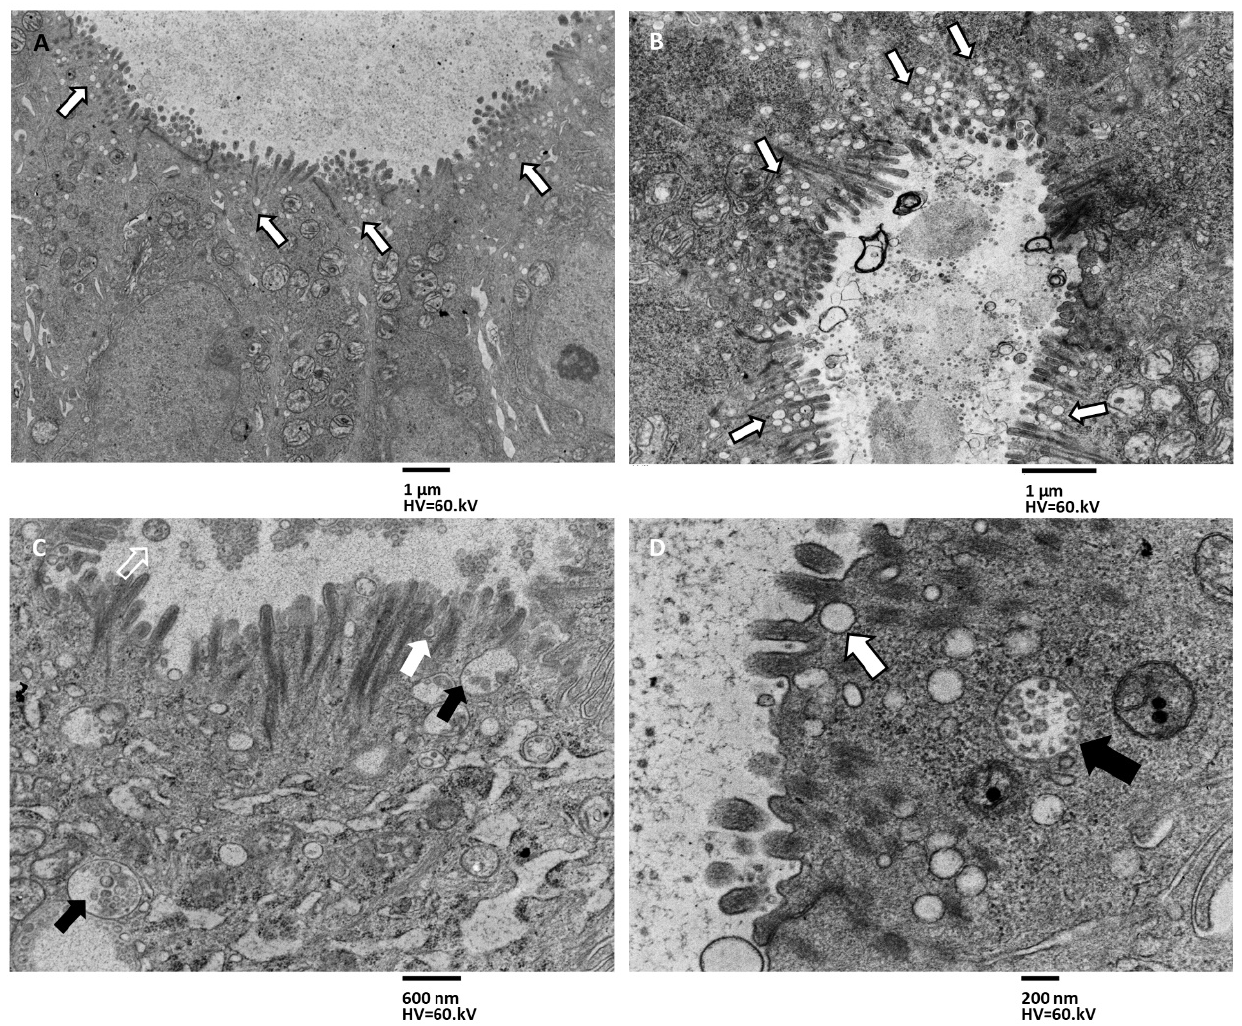
Figure 6. TEM images of exosomes secretion pattern in xenografts, apical surface secretion. ( A ) Numerous MVBs crowd the apical portion of pseudocyst lining epithelial cells, magnifica- tion 1600 × , bar 1 µ m. ( B ) MVBs accumulate just beneath the apical membrane, aligning in rows (arrows); the cyst lumen is filled with exosomes, with a magnification of 1600 × , bar 1 µ m. ( C ) MVBs (black arrows) travel across the cytoplasm, reaching the cell membrane and creeping into the narrow spaces among the microvilli base. Then they fuse with the plasmatic membrane (with arrow) and free their content into the cyst lumen. Sometimes entire MVBs are secreted (with an empty arrow), magnification 6300 × , bar 600 nm. ( D ) At higher magnifications, MVBs filled with exosomes are visible (black arrow), and others approaching the plasmatic membrane are present (white arrow), magnification 12,500 × , bar 200 nm. The different patterns of secretion in MTSs and xenografts at both the apical and baso- lateral membranes, secretion in MTSs and xenograft is shown in Figure 8. In MTSs samples, few and sparse MVBs are aligned in one horizontal row just beneath the apical plasmatic membrane. In xenografts, MVBs are aligned in several vertical columns perpendicular to the apical plasmatic membrane (Figure 8A,B; see also Figure 6). Few MVBs approach the basolateral membrane in MTSs, while groups of generally four or five MVBs are visible near the basolateral membrane in the xenografts (Figure